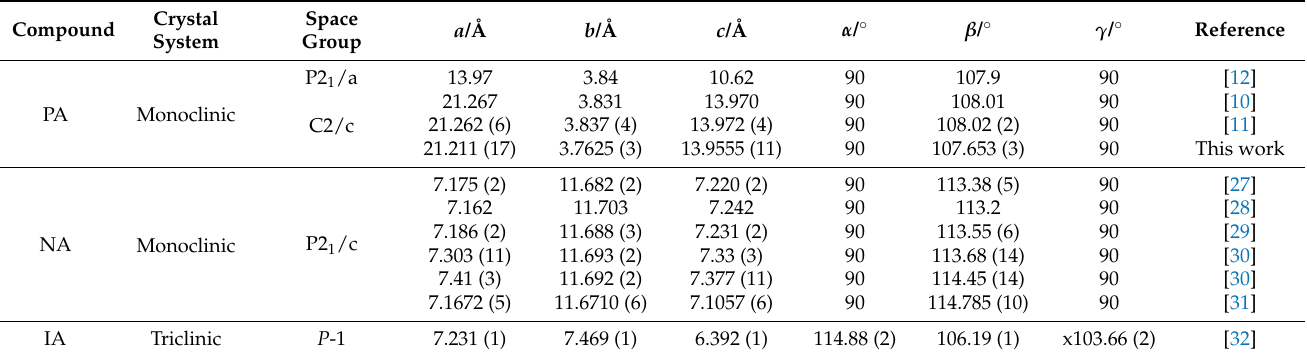
Table 6. Picolinic, nicotinic and isonicotinic acids crystal systems, spaced groups and cell parameters gathered from literature SCXRD